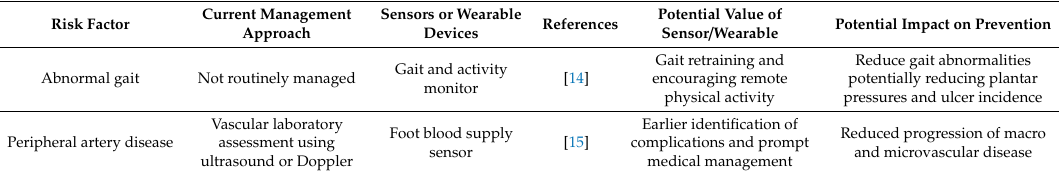
Legend: The table outlines the risk factors for the development of diabetes-related foot disease and how sensors and wearables could be used to remotely monitor these factors. References are provided for the relevant research articles assessing the impact or implementation of such technologies for further